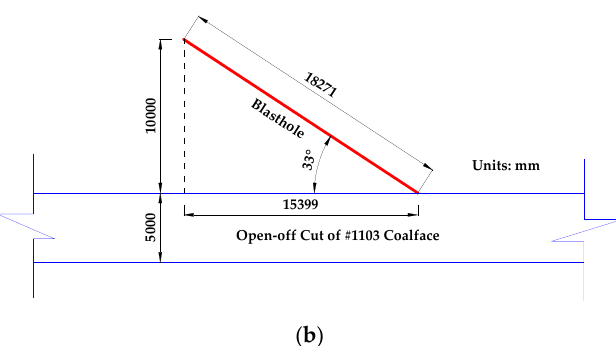
Figure 18. Layout of blastholes above the open-off cut and relevant parameters: ( a ) layout of blastholes; ( b ) profile of a blasthole.